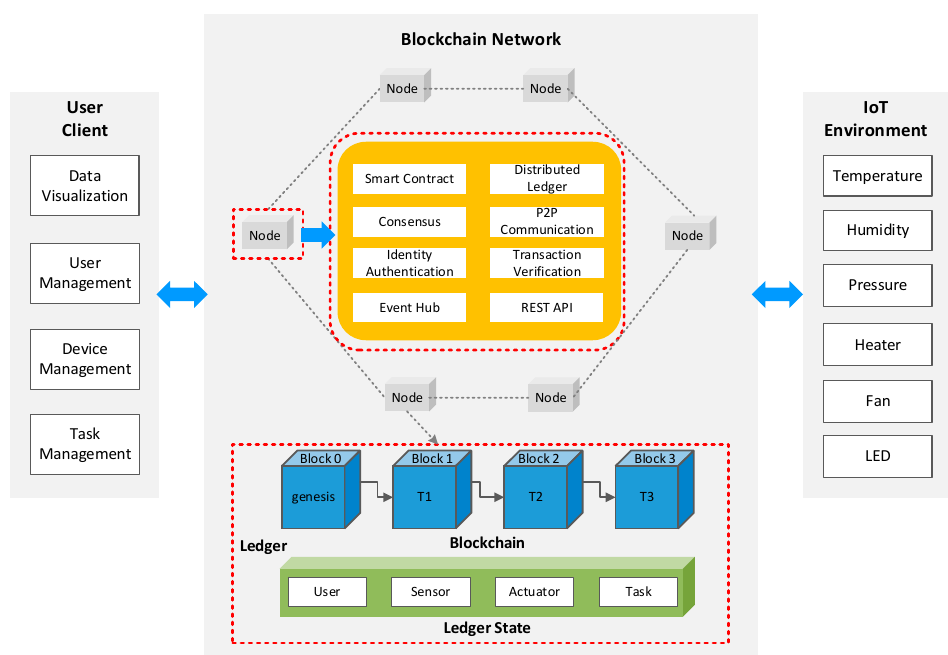
Figure 3. The detailed structure of the blockchain network.